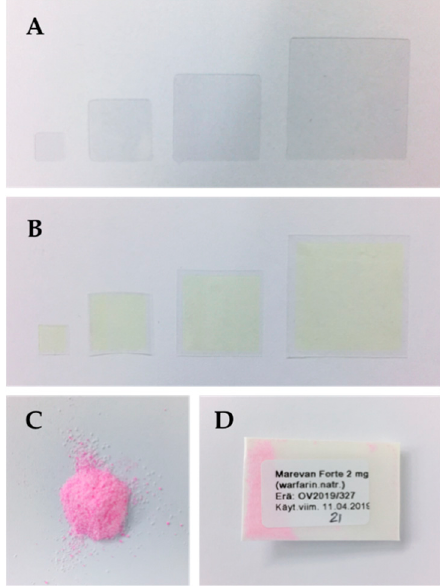
Figure 3. Pictures of the prepared dosage forms: ( A ) EXT ODFs; ( B ) IJP ODFs; ( C ) oral powder; and ( D ) OPS .